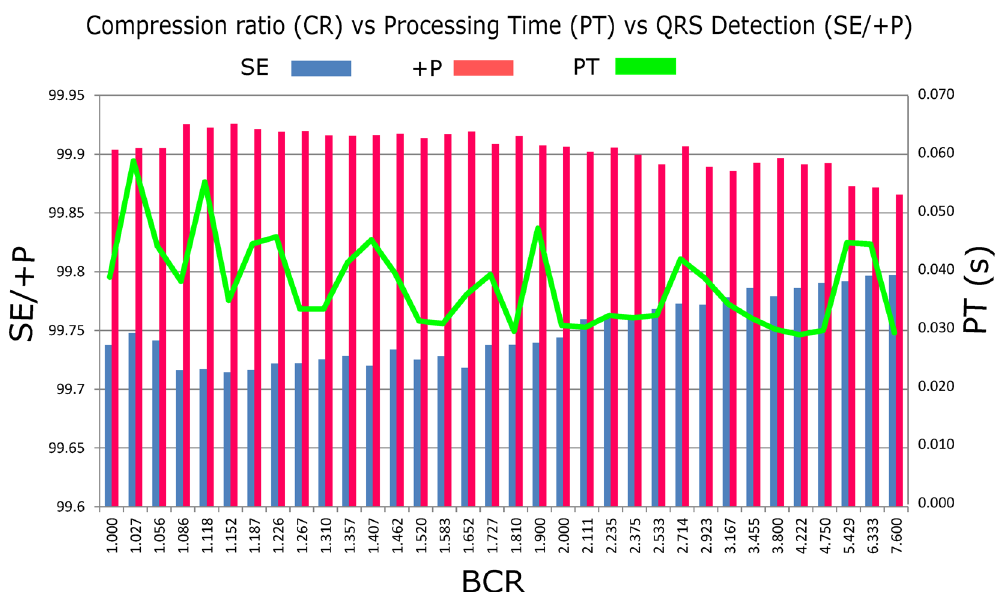
Figure 5. Compression ratio versus performance. Here, BCR stands for bit compression ratio, PT stands for average processing time, SE stands for sensitivity, and + P stands for positive